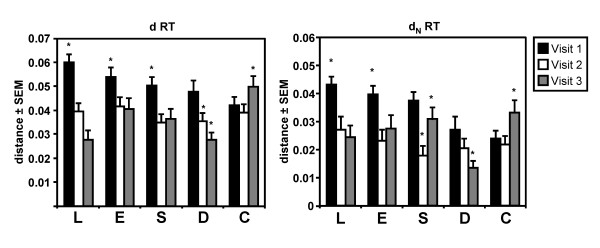
Viral interpatient diversity of the RT-coding region in the gut tissues (esophagus (E), stomach (S), duodenum (D), colon (C)) and PBL (L) of HIV-1 infected patients at different visits. Viral RT-coding sequences tended to a more conserved sequence among patients in the esophagus, stomach, duodenum and PBL, as reflected by the lower mean total distance (d) between patients, while the sequences in the colon became more diverse over time. Similarly, the decrease in mean total non-synonomous distance (dN, i.e. amino acid changing mutations) for PBL and duodenum suggested evolution towards more conserved RT protein sequences over time among patients, while the increased dN reflected the RT protein sequence becoming more diverse over time in the colon among patients. These observations indicated that the RT-coding region evolved differently in the different gut tissues and PBL in this group of patients. (* p < 0.05, Dunnett C post-hoc analysis)